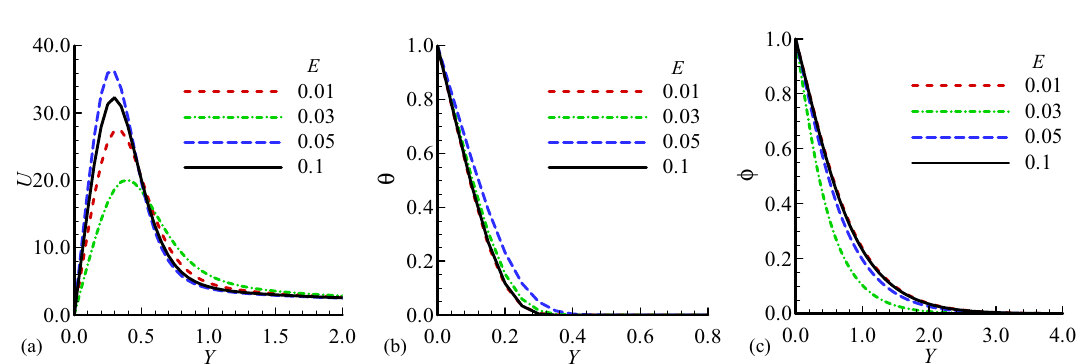
Figure 7. Dimensionless ( a ) Velocity U , ( b ) temperature θ and ( c ) mass distribution φ for different values of γ = 0.01, 0.25, 0.03, 0.05 while n = 0.3 , E = 0.8 , γ = 0.2 , (cid:31) = 0.5 , β = 0.5 , (cid:31) T = 15.0 , (cid:31) c = 10.0, Pr = 7.0, Sc = 0.2.